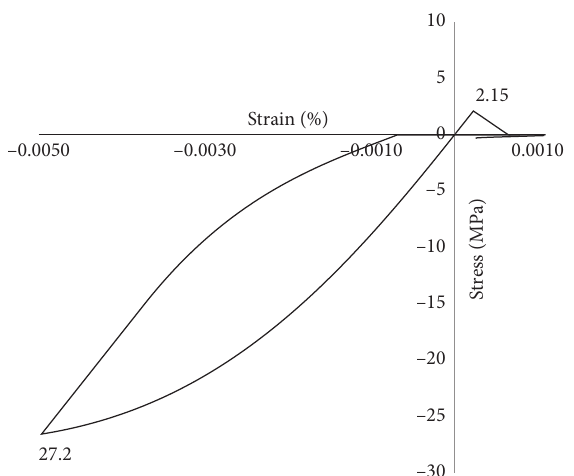
Figure 3: Typical uniaxial stress-strain curve as defined by the Total Strain Crack model with Maekawa–Fukuura compressive